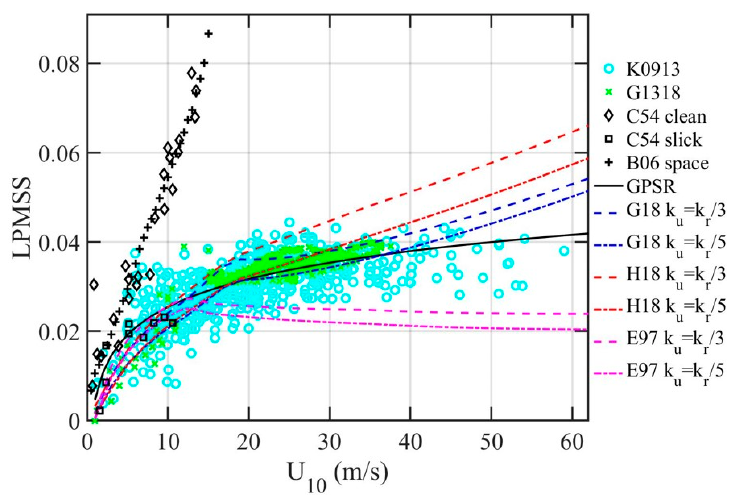
Figure 5. L band LPMSS derived from GPSR delay Doppler analyses (labeled K0913 and G1318), the least-squares curve fitted through all the GPSR data is given by the solid black line (labeled GPSR). Three sets of computation from spectrum models (E97, G18, and H18) with k u = k r /3 and k r /5 are also illustrated. For comparison, optical MSS in clean and slick waters is shown with black markers.